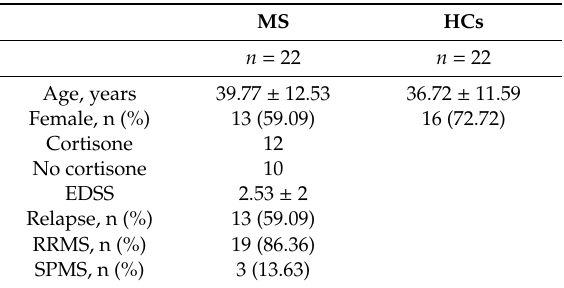
Table 1. Demographic and clinical characteristics of MS patients and HCs.